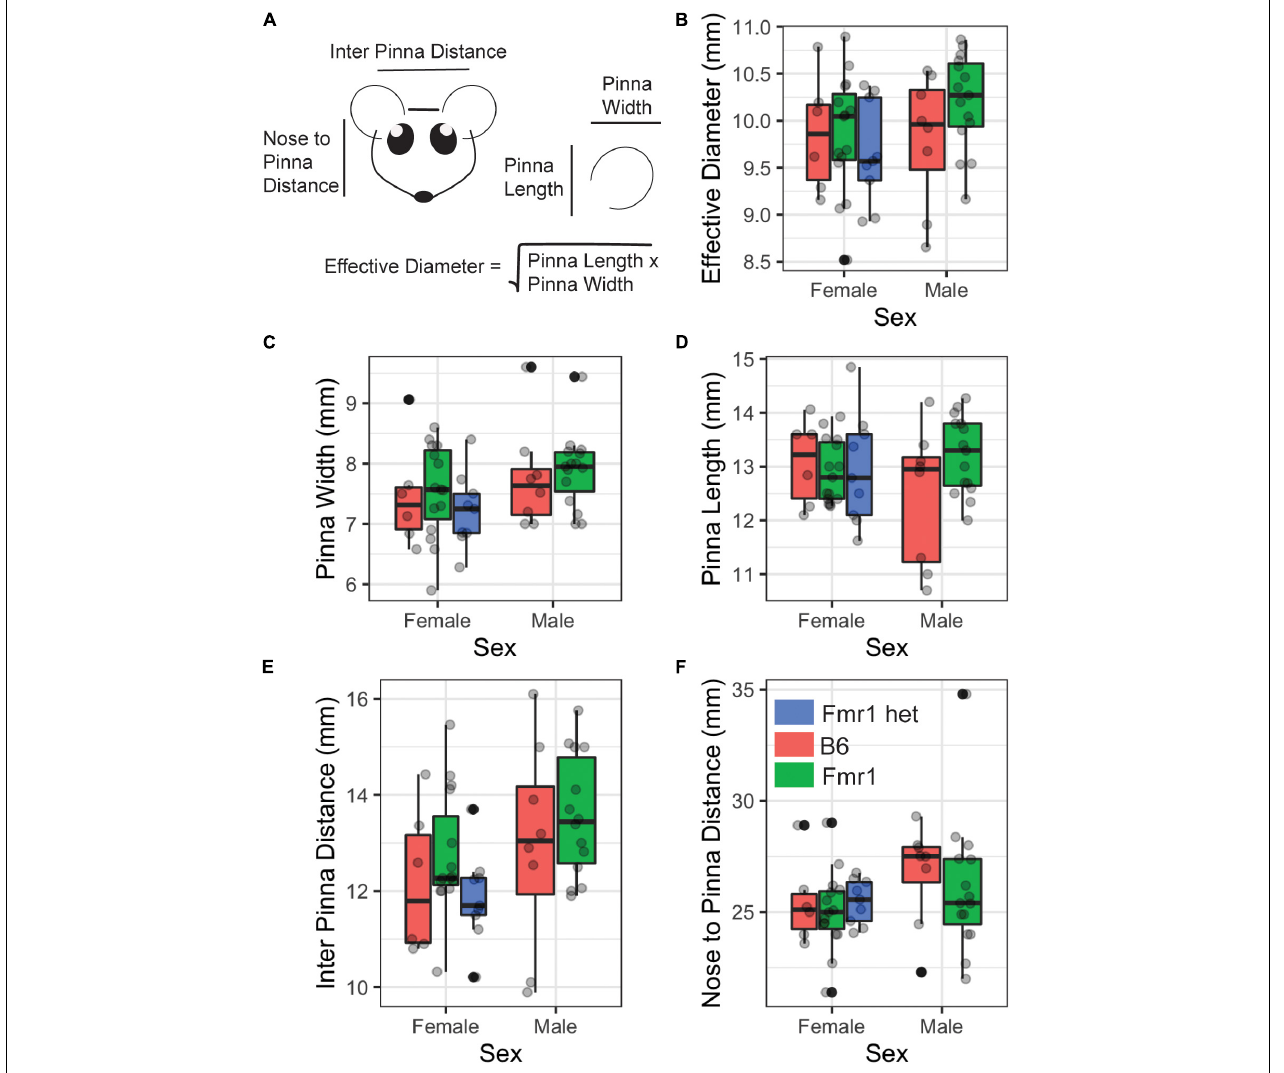
FIGURE 1 | Morphological features of Fragile X syndrome (FXS) mice. Pinna and head features (A) were measured between the sexes ( x -axis) and genotypes (purple = B6, teal = Fmr1, and yellow = Fmr1 het). There was no difference between the sexes or genotypes for any of the measures [effective diameter (B) , pinna width (C) , pinna length (D) , interpinna length (E) , or nose to pinna length (F) ]. Data represent 6 B6, 15 Fmr1, and 9 Fmr1 het females and 8 B6 and 15 Fmr1 males.